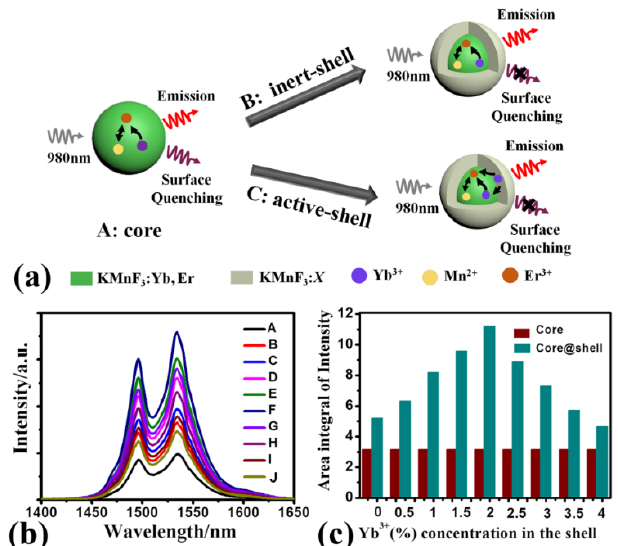
Figure 6. ( a ) Schematic illustration of KMnF 3 :18%Yb 3+ ,1%Er 3+ NPs, KMnF 3 :18%Yb 3+ ,1%Er 3+ @KMnF